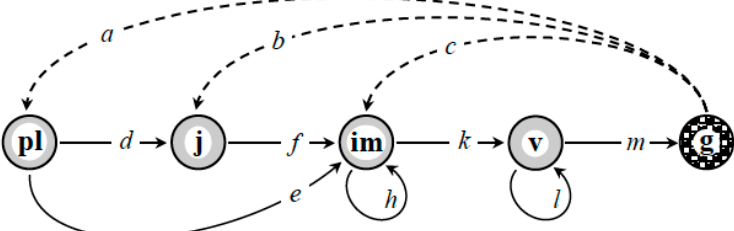
Figure 2. Life cycle graph for a local population of Androsace albana observed once per year. Ontogenetic stage notations as in Figure 1. Solid arrows indicate transitions occurring for one year (no transitions, in particular); dashed arrows correspond to annual recruitment